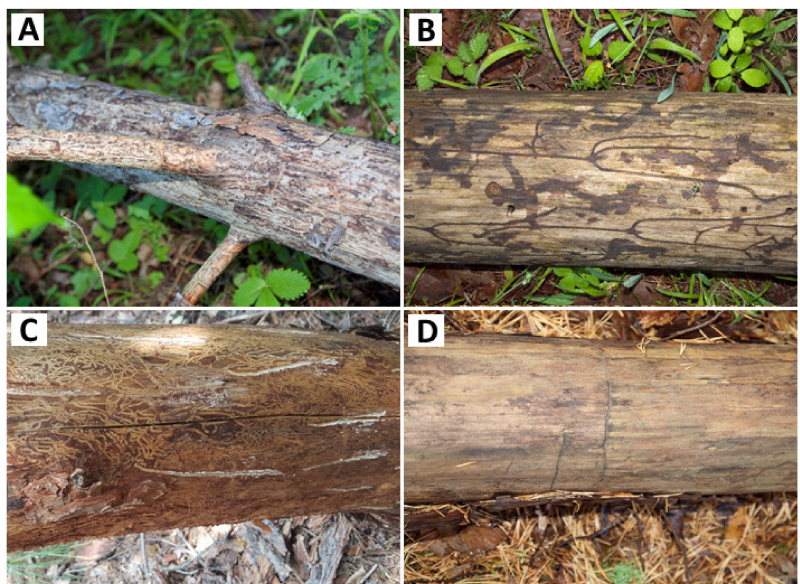
Figure 9. Insect pest and fungal pathogens in studied areas: ( A ) Ips acuminatus (Kirkovo, Pinus sylvestris , 8 June 2020); ( B ) Ips sexdentatus (Kirkovo, Pinus sylvestris , 8 June 2020); ( C ) Tomicus piniperda (Fotinovo, Pinus nigra , 8 June 2020); ( D ) Tomicus minor (Kirkovo, Pinus sylvestris , 8 June